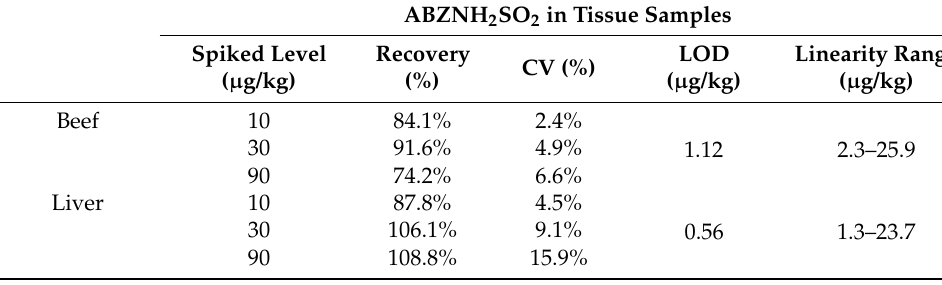
Table 5. Recoveries, CVs, LODs, and linearity range of ABZNH 2 SO 2 in spiked tissue samples using ic-ELISA. ( n =